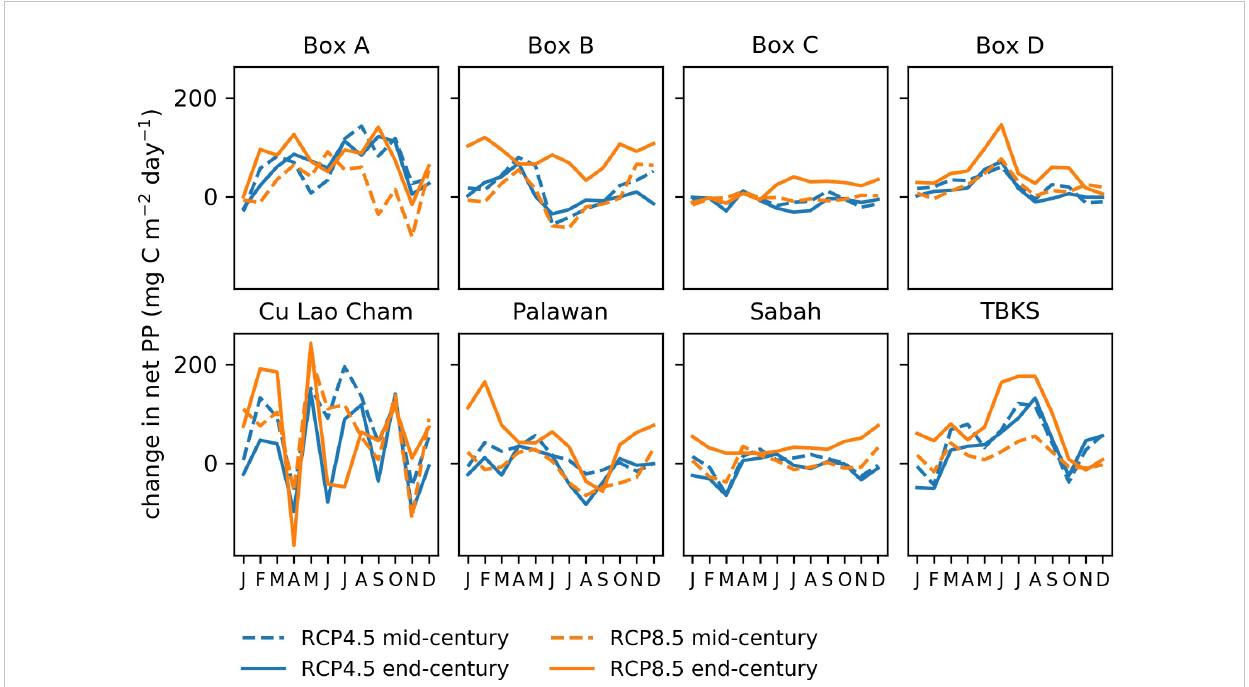
FIGURE 8 Projected change in monthly mean net primary production compared to present day for 8 sample areas, for mid-century (dashed lines) and end- century (solid lines). Blue lines show RCP4.5 and orange lines RCP8.5. Values are averaged over 20-year time periods: 2000-2019, 2040-2059 and 2079-2098. See Figure 1 for sample area